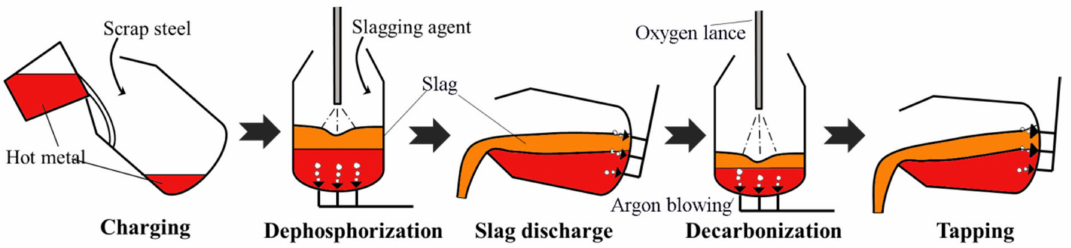
Figure 1. Flow chart of integrating dephosphorization and decarburization in a single converter (IDDSC)